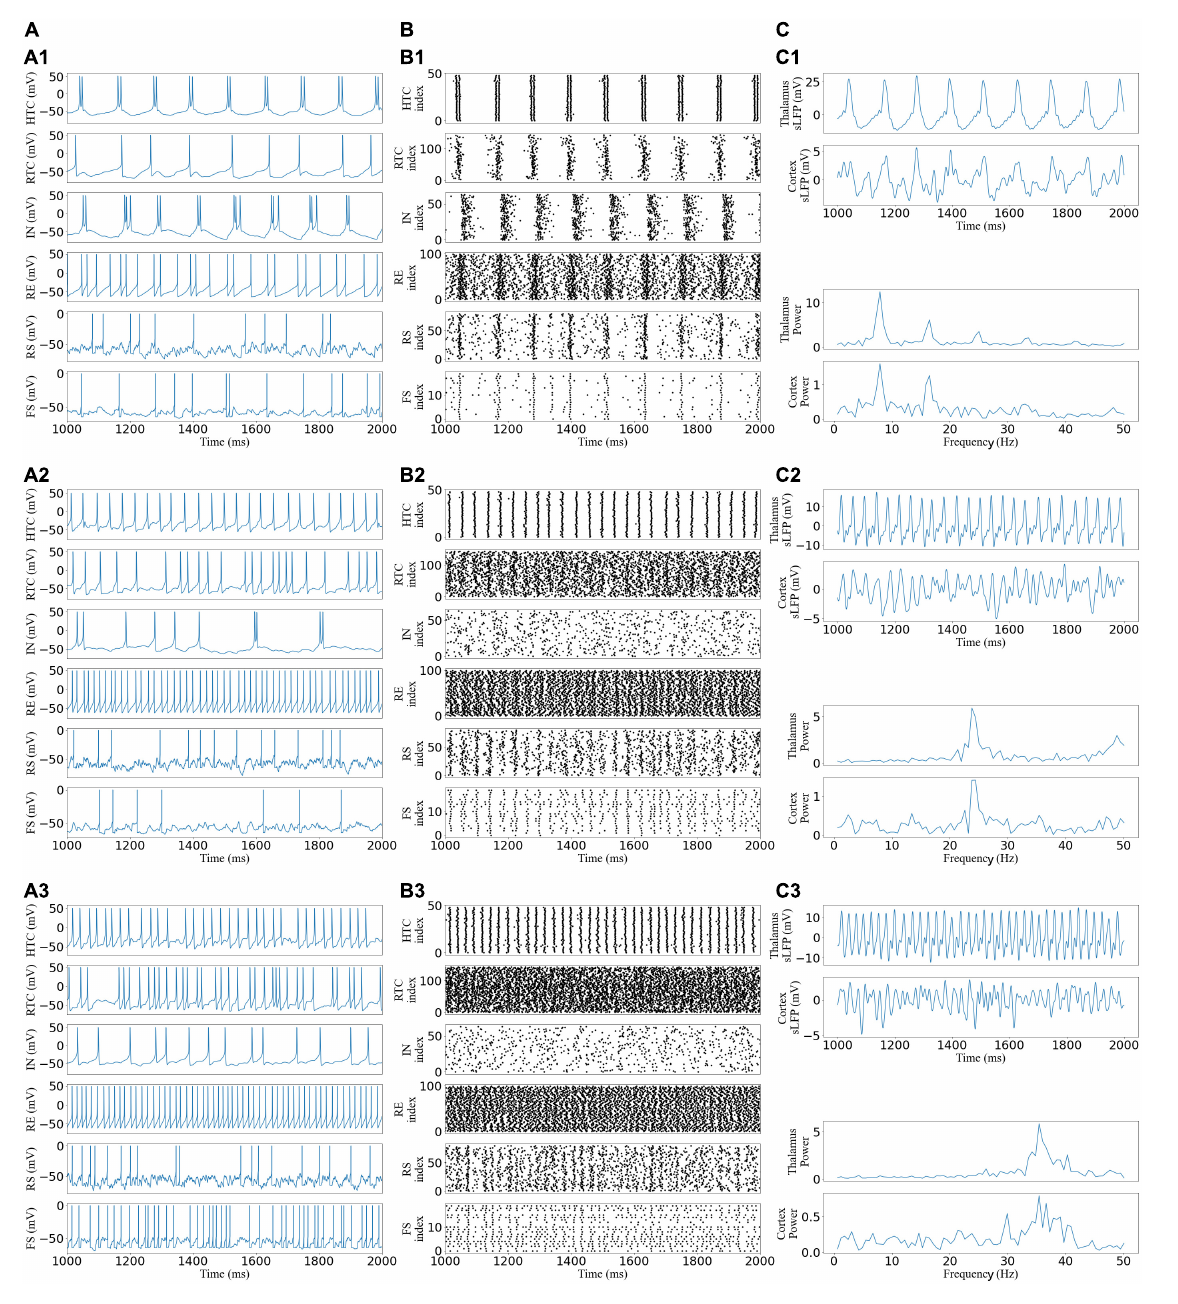
FIGURE2 Generation of alpha, beta, and gamma oscillatory states in the TCO NN model under different afferent excitations. (A) Voltage traces of representative HTC, IN, RTC, RE, RS, and FS cells each: (A1,A2) alpha, beta, and gamma oscillatory states, respectively. (B) Spike rastergrams of HTC, IN, RTC, RE, RS, and FS cells. (C) Simulated LFP (top) of thalamus and cortex networks with associated frequency power spectrum